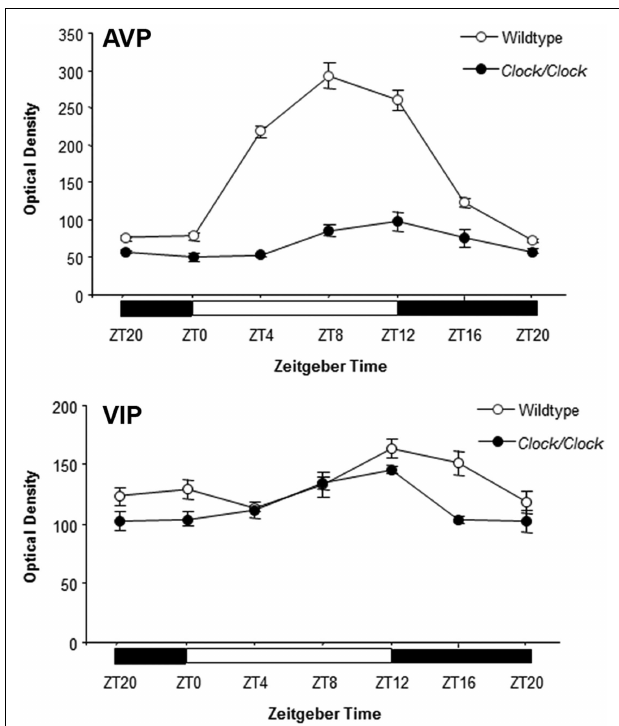
FIGURE 2 |AVP andVIP expression in the SCN . AVP andVIP mRNA levels were measured by autoradiography in the SCN from wildtype and Clock/Clock mice. Both AVP andVIP showed circadian expression in wildtype SCN. In Clock mutants,VIP expression was similar to that observed in wildtype mice, but AVP expression and rhythmicity was significantly damped. Modified from data presented in Ref.